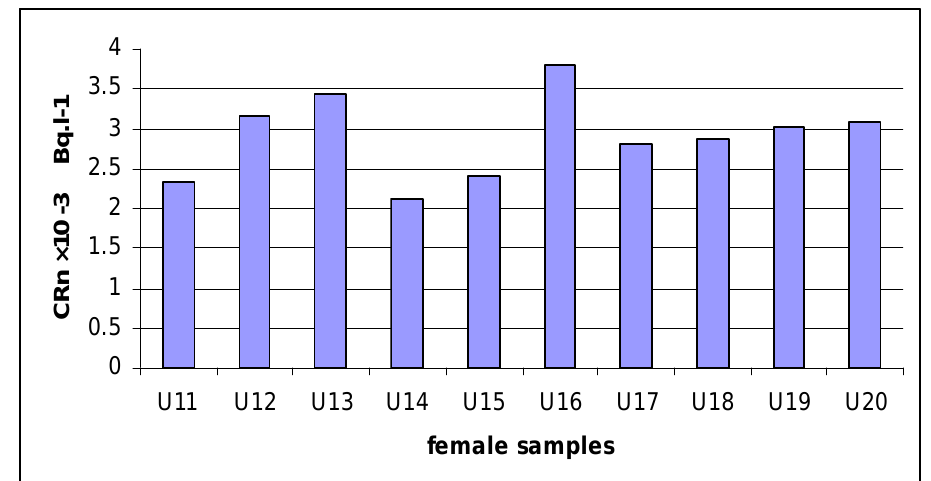
Fig. 5: Radon concentration of female urine human